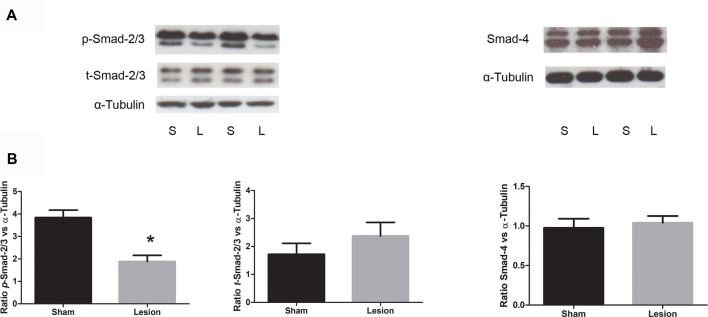
Expression of TGF-β signaling protein from sham and NVHL animals from medial PFC at PD60. (A) Representative Western blots showing the expression of phospho (p)-Smad2/3, (total) t-Smad-2/3, total-Smad-4 and α-tubulin in samples prepared from medial PFC tissue of sham (S) and NVHL (L) rats. The blot was developed for p-Smad-2/3, stripped and probed for t-Smad-2/3 and restriped and reprobed for α-tubulin antibody. (B) Quantitation of Western blotting data (relative optical densities (ROD) ratio of p-Smad-2/3, t-Smad-2/3 and Smad-4 over α-tubulin). A significant decrease in p-Smad-2/3 was observed in NVHL rats (*p = 0.003). No significant change in the normalized levels of t-Smad-2/3 and Smad-4 was observed between sham and lesion group (n = 5–6 per group).